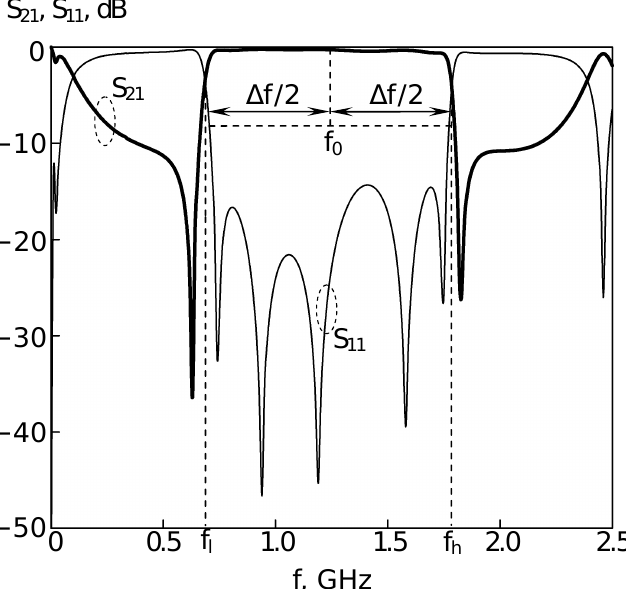
Figure 6. AFC of the W-shaped (studs with a plume) 5-mode resonator. Points – experimental data, lines – theoretical data (results of electrodynamic